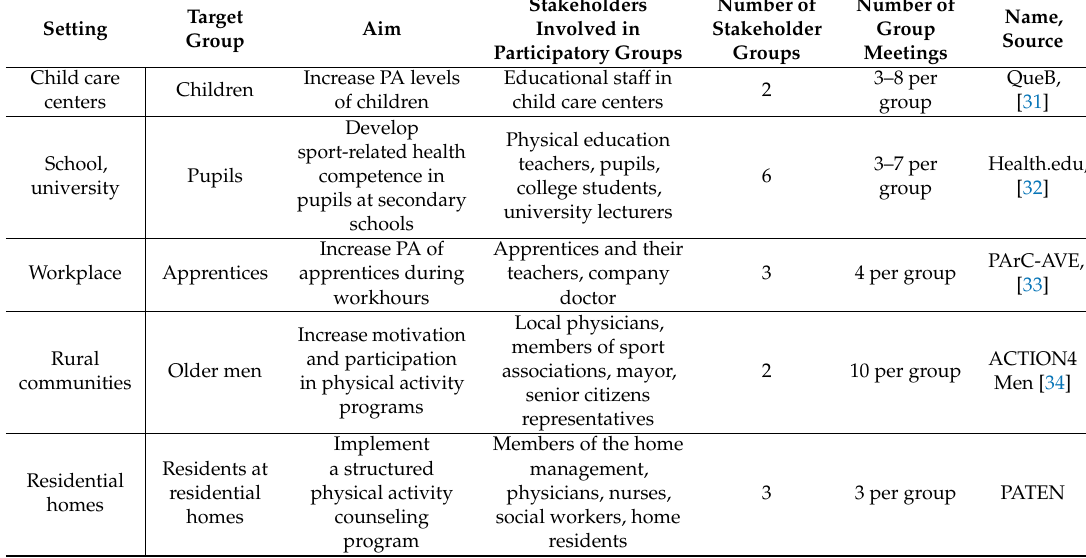
Table 1. Stakeholder group composition in the di ff erent subprojects of the Capital4Health consortium.